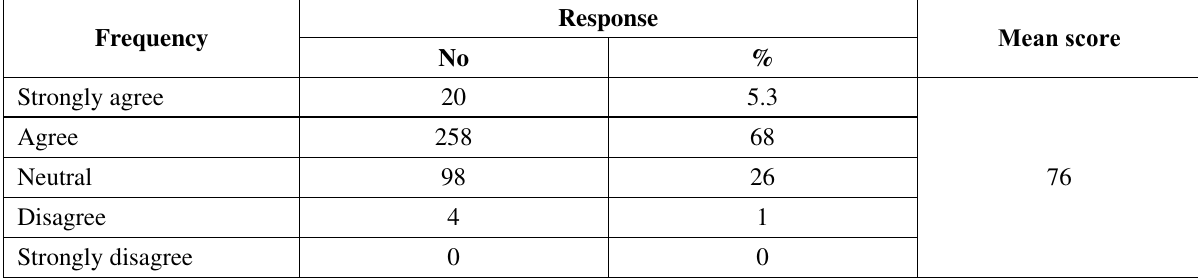
Figure 2. Theoretical proposition 2: PPP project management